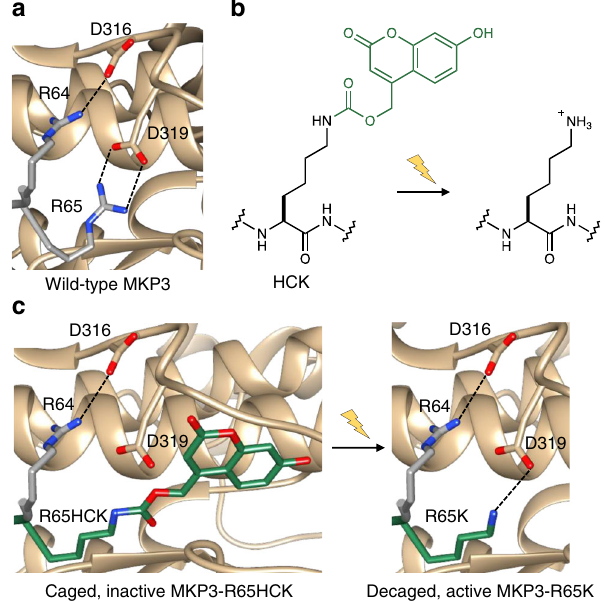
Fig. 4 Design strategy for optical control of the phosphatase-kinase interaction motif (KIM). a The crystal structure of ERK2 (tan) bound to the KIM peptide of MKP3 (gray) shows essential electrostatic interactions of R64 and R65 with D316 and D319 (PDB: 2FYS). b Irradiation of HCK removes the coumarin caging group (green) and restores a native lysine residue. c Replacement of R65 with HCK generates steric hindrance and prevents electrostatic interaction until light exposure release K65, which enables the ERK2-MKP3